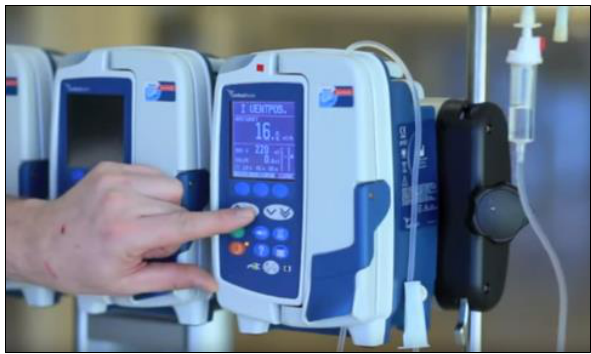
Figure 1: Infusion pump that is used in Rijnstate hospital (Carefusion,